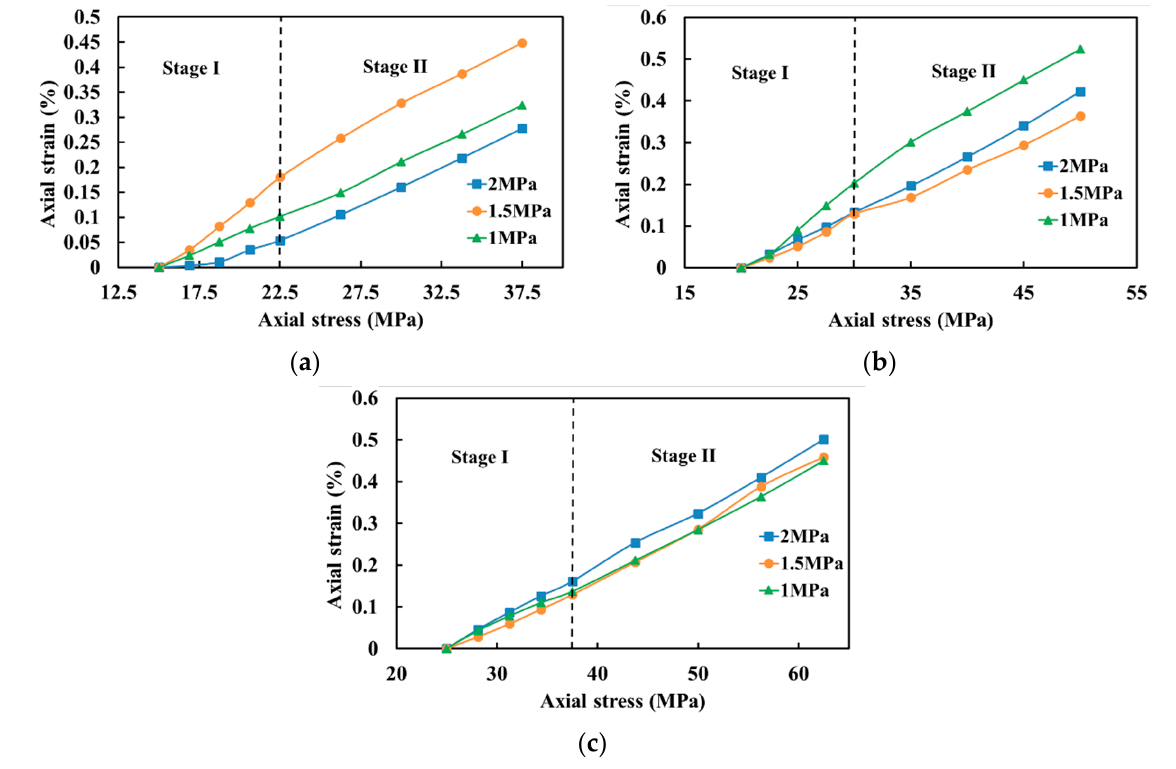
Figure 4. Axial strain variation of sandstone under different initial confining pressures (( a – c ) are the initial confining pressure of 15 MPa, 20 MPa, and 25 MPa, respectively).